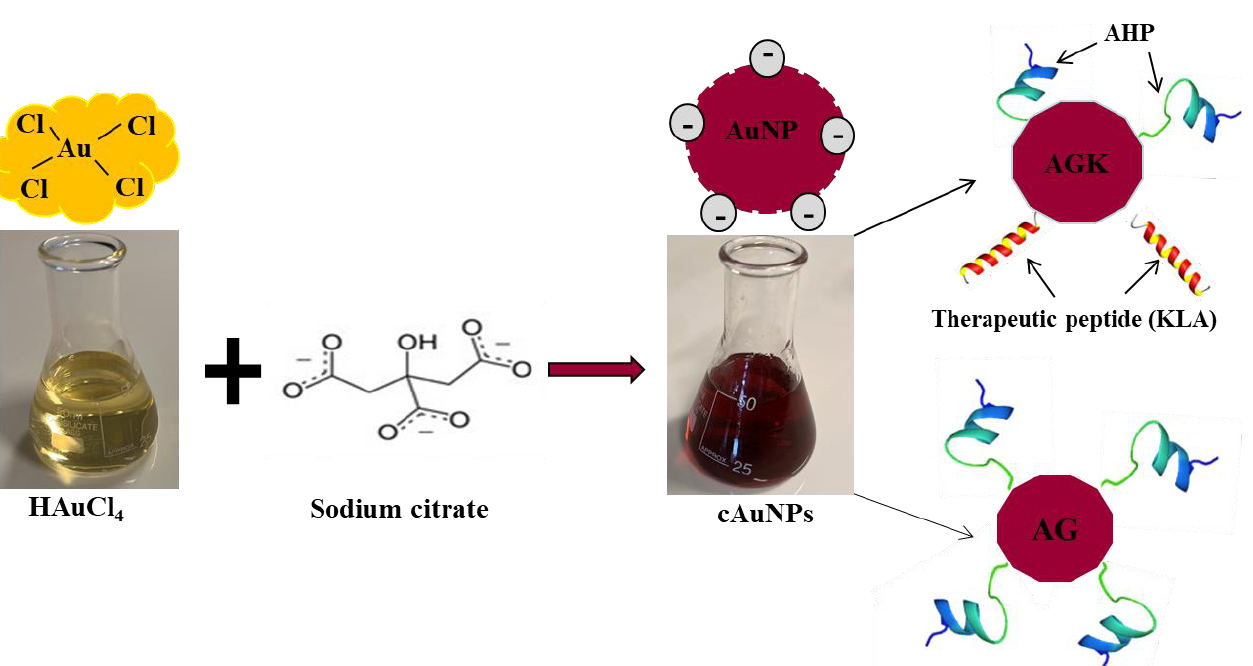
Figure 1. Chemical synthesis and bio-functionalization of AuNPs with AHP (AG), and both AHP and KLA (AGK)